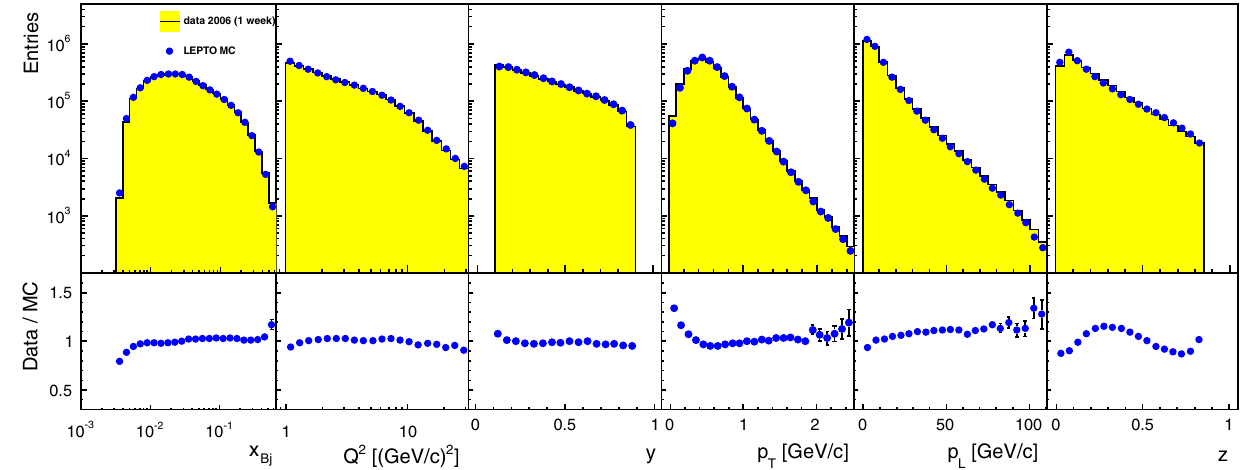
Fig. 2 Comparison of kinematic distributions from data and MC simulations ( top panels ) and their ratio ( bottom panels ) for the lepton variables x Bj , Q 2 , y and for p T , p L and z of the hadron leading in p T , normalised to the number of events